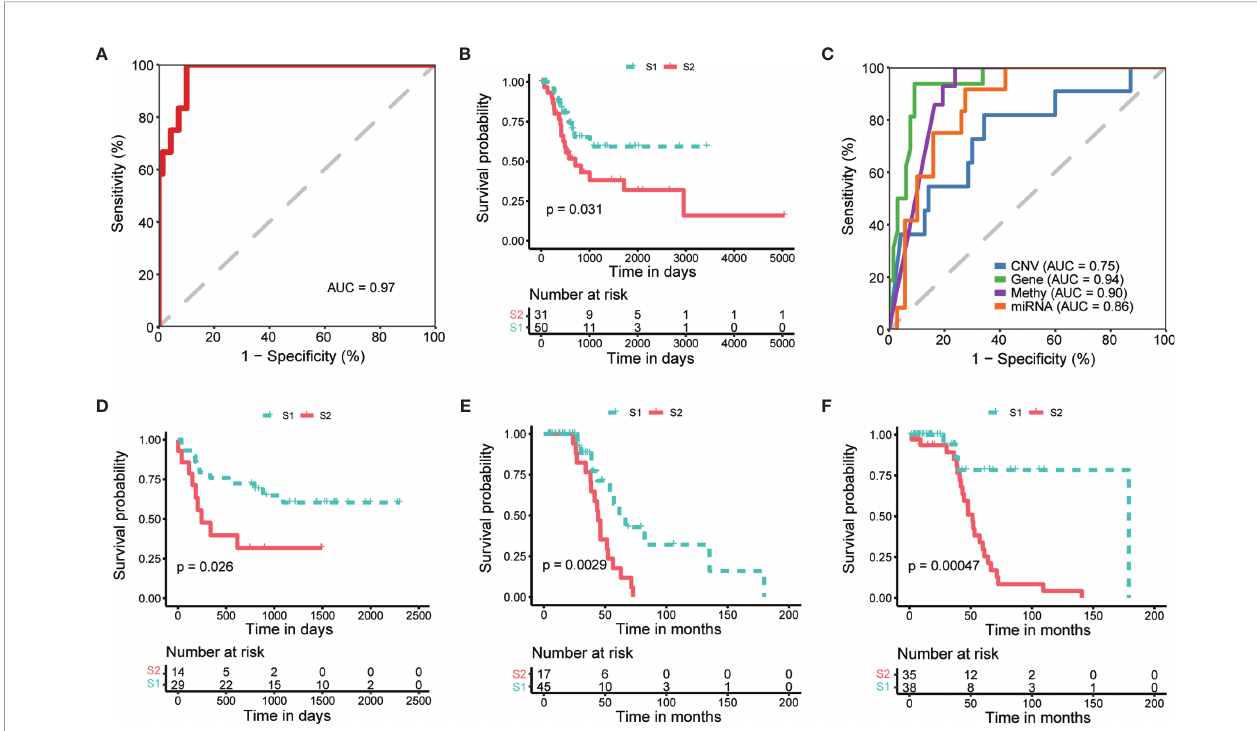
FIGURE 4 | Internal and external validation of prognostic subtyping. (A) ROC analysis shows the robustness of subgroup classi fi cation in internal testing dataset using multi-omics data. (B) Kaplan-Meier curves show a signi fi cant difference of overall survival between subtypes predicted by multi-omics data in internal testing dataset. (C) ROC analysis shows the robustness of subgroup classi fi cation in internal testing dataset using each single omics data, respectively. (D – F) . Kaplan-Meier curves show a signi fi cant difference of overall survival between subtypes in external datasets, including GSE19915 (D) and two subsets of GSE48277 (E, F) ,